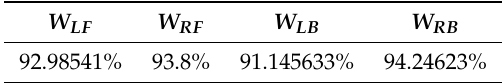
Table 5. The accuracy of weight vector on training